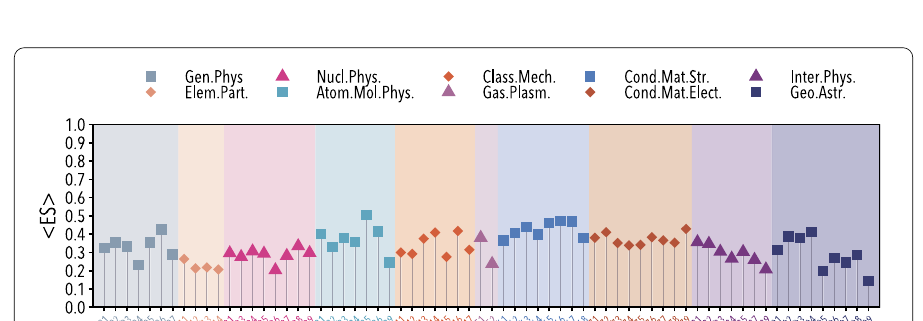
Figure 5 Cosine similarity distribution of authors’ interest between the first and 5th year of their careers measured using the second level of the classification scheme. (panel ( A )) For authors with a career duration of exactly 5 years. (panel ( B )) for authors with a career duration of 10 years or larger and (panel ( C )) the relative change between the